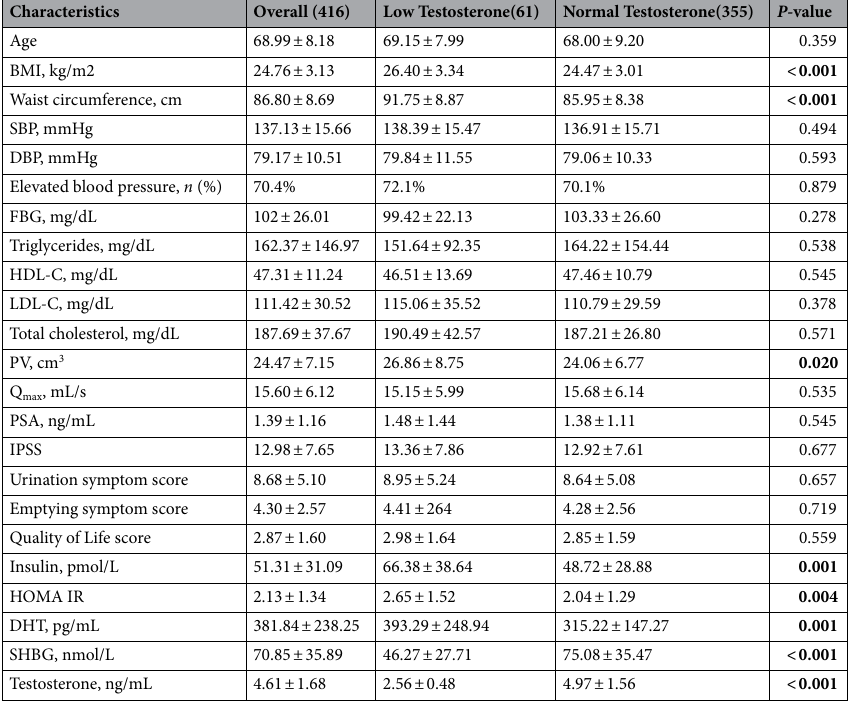
Table 1. Baseline characteristics. P were calculated by independent t-test† and chi-squared test‡. Bold indicates statistically significant values. The total number of subjects was 416. BMI body mass index,